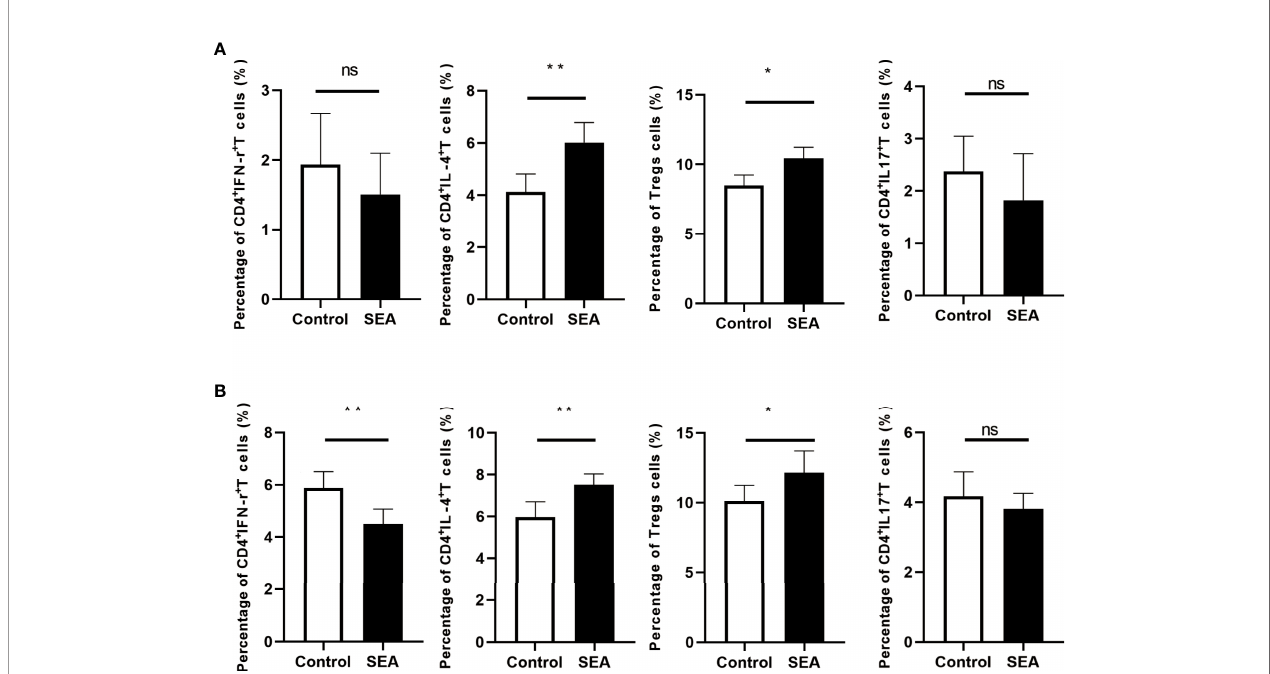
FIGURE 6 | T-cell subsets in the spleen of mice in each group were analyzed by fl ow cytometry on day 28 after SEA treatment and on day 7 after skin transplantation. (A) Compared with the control group, on the 28th day after SEA treatment, the percentages of CD4 + IL-4 + T and Treg cells in the spleen of mice in the experimental group were signi fi cantly upregulated, while CD4 + IFN- g + and CD4 + IL-17 + T-cell ratios were not signi fi cantly different. * p < 0.05, ** p < 0.01, n = 6. (B) On the 7th day after transplantation, the percentages of CD4 + IL-4 + T and Treg cells in the spleen of mice in the experimental group were still signi fi cantly upregulated compared with the control group, and there was no signi fi cant difference in the ratio of CD4 + IL-17 + T cells, but compared with the control group, the percentage of CD4 + IFN- g + T cells was signi fi cantly decreased. * p < 0.05, ** p < 0.01, n =